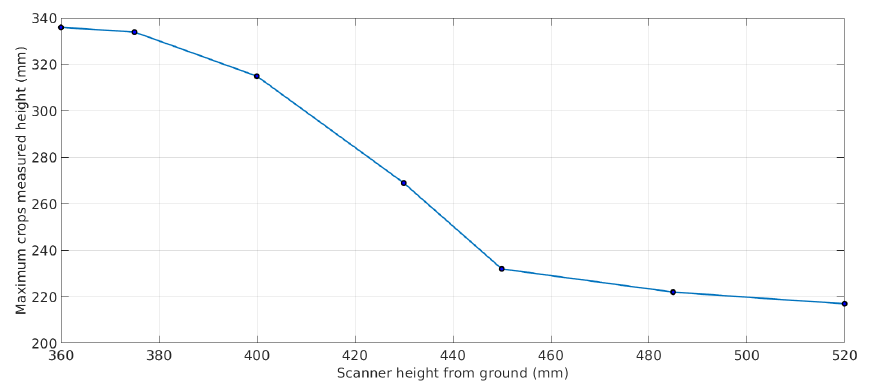
Figure 12. Scanning results. Maximum measured height vs ToF sensor altitude.